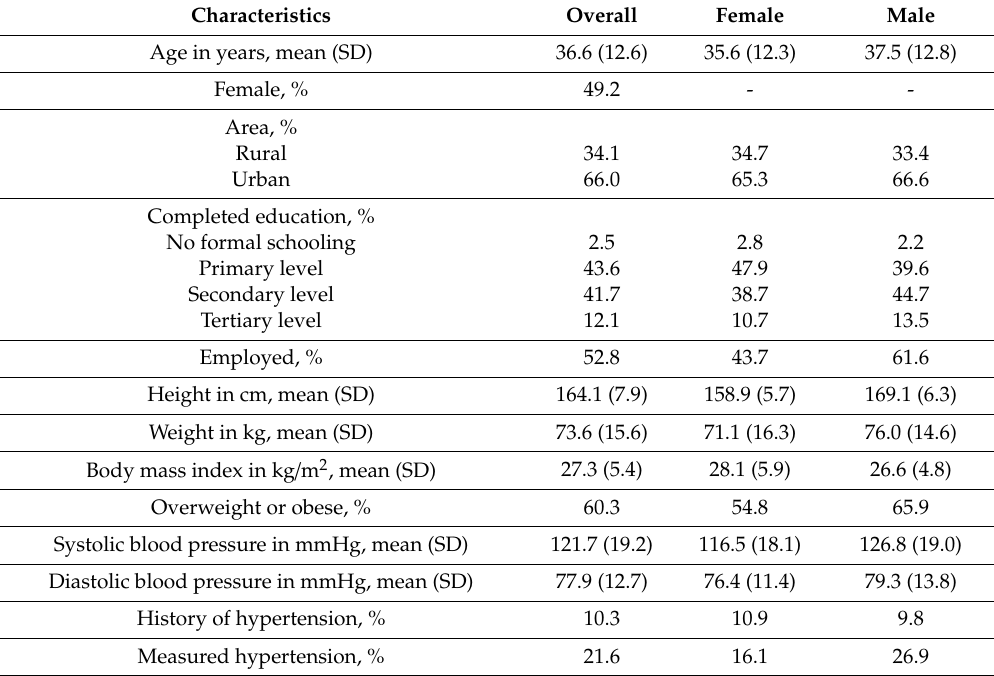
Table 1. Weighted sample